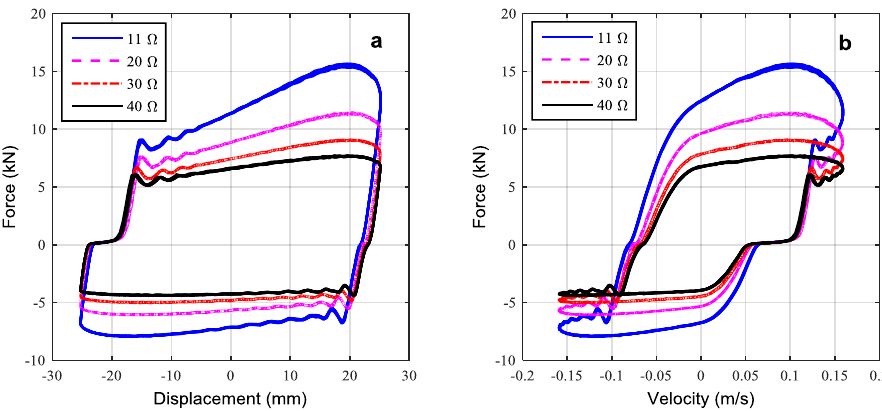
Figure 15. ( a ) Measured displacement-force loops; ( b ) measured velocity-force loops, at 11 Ω, 20 Ω, 30 Ω and 40 Ω load resistances.